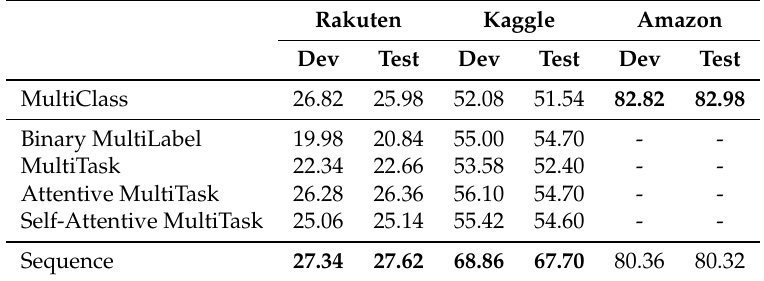
Table 2. Full-chain accuracy of all models on all